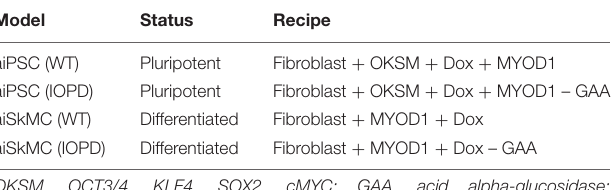
TABLE 1 | Summary of evaluated study